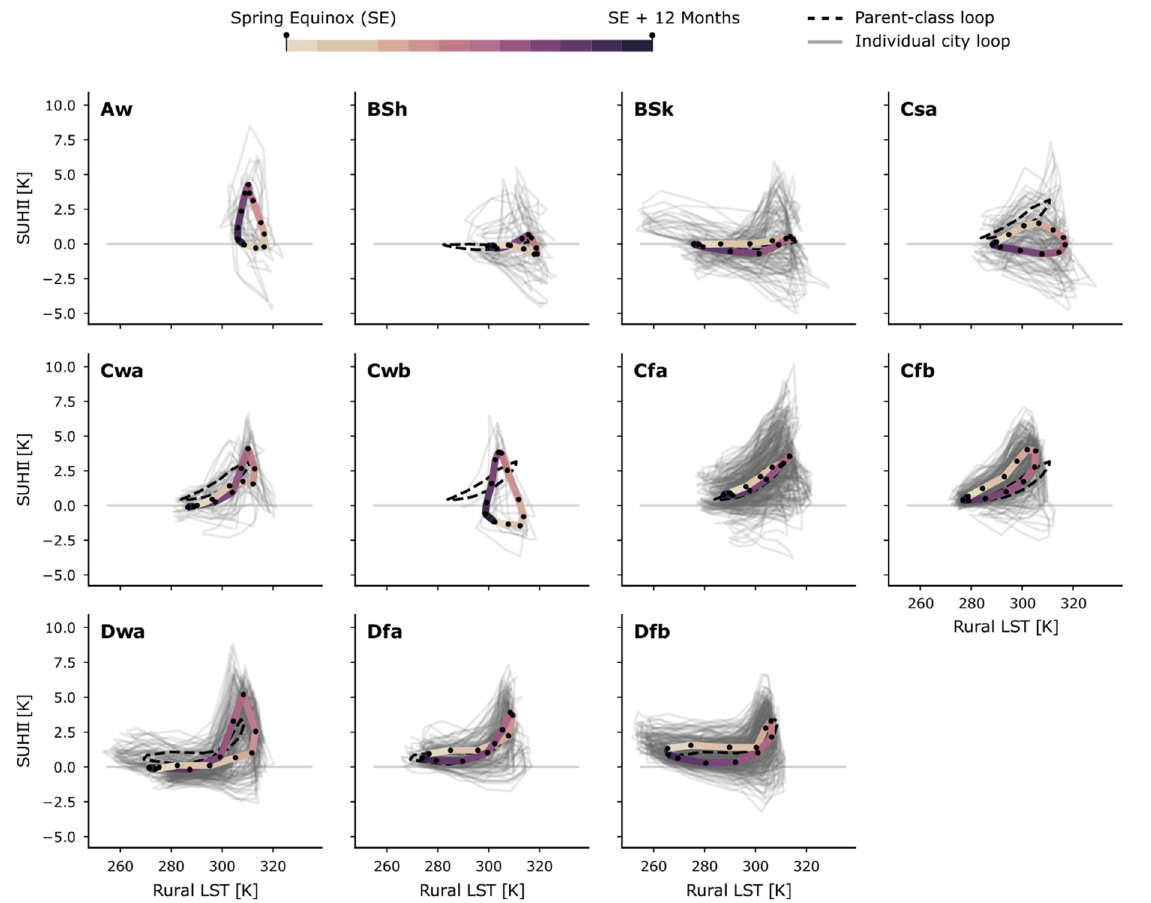
Figure 3. The daytime SUHII hysteresis loops for each Köppen–Geiger climate class (colored lines). Each black dot represents a month (the start and end points correspond to spring equinox), and the change in color indicates the direction of each loop. The solid grey loops represent the individual city loops per climate class, and the dashed one represents the corresponding parent-class loops.